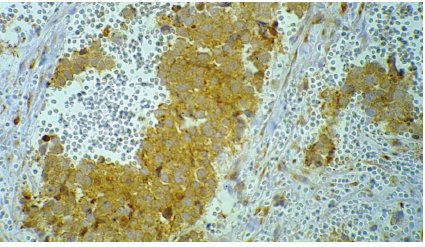
Figure 5: Small round cell tumor in hemorrhagic fibrovascular background.